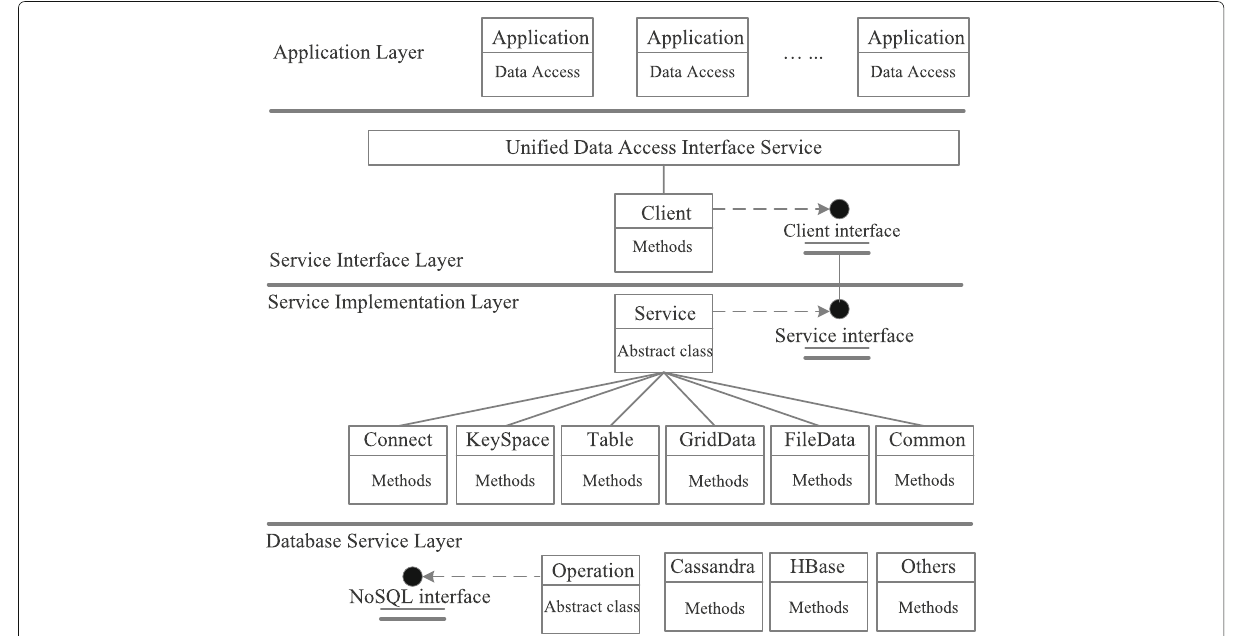
Fig. 8 Unified service architecture for meteorological data services